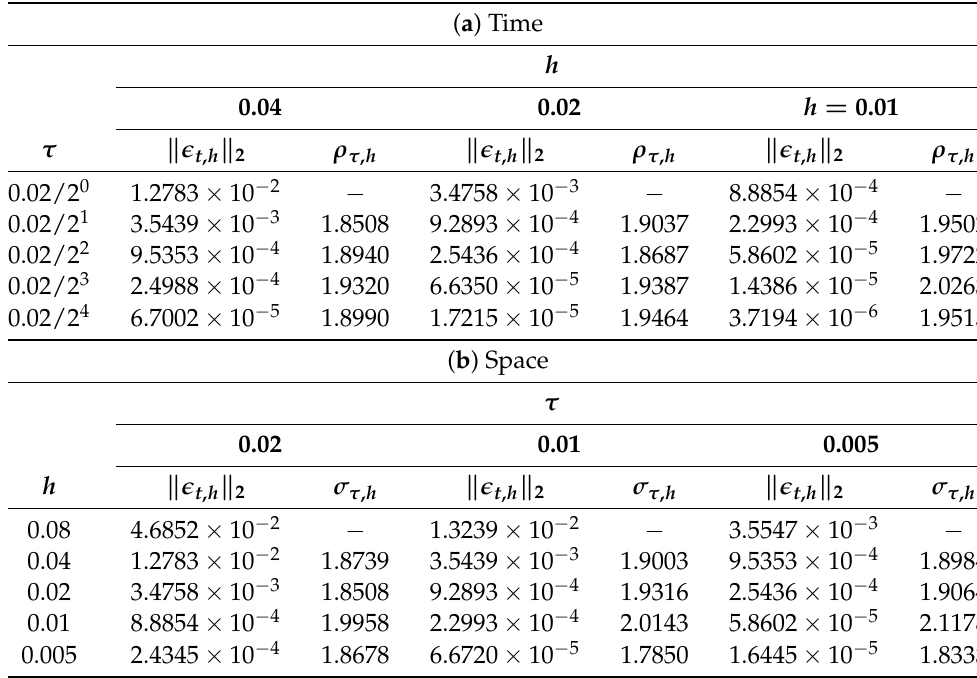
Figure 3. Graphs of the approximate solutions of problem (4) vs. ( x , t ) , employing α 1 = α 2 = 1.0, h 1 = 0.1 and τ = 0.01. The graphs show ( a ) Re Ψ 1 , ( b ) Re Ψ 2 , ( c ) Im Ψ 1 , ( d ) Im Ψ 2 , ( e ) | Ψ 1 | and ( f ) | Ψ 2 | . Table 1. Computational study of